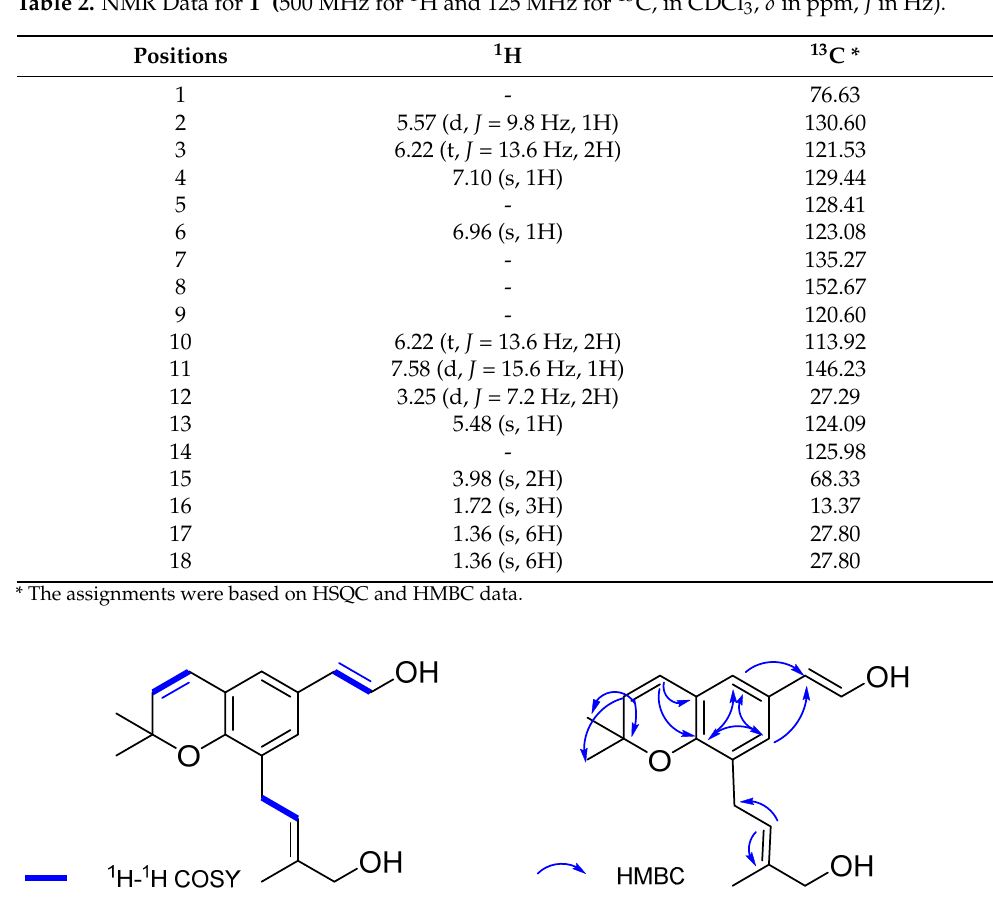
Table 2. . NMR Data for 1 ʹ ( 500 MHz for 1 H and 125 MHz for 13 C, in CDCl 3 , δ in ppm, J in Hz).